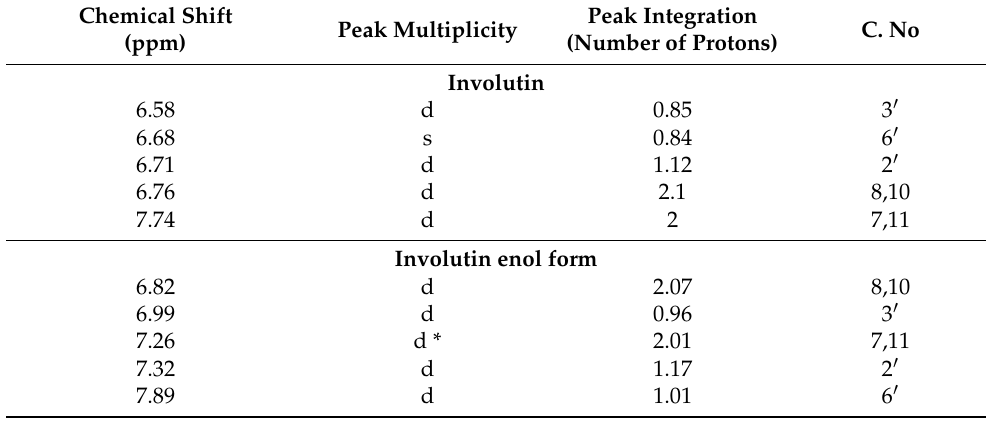
Table 3. Assignment of the peaks in 1 H NMR spectra (at 500 MHz) of HPLC-purified involutin in the region of 6.5 to 7.9 ppm. The multiplicity and integrals are relative to the most stable involutin form and a tautomeric form (enol). Multiplicity: singlet (s), doublet (d) and distorted doublet (d *). The NMR spectra are shown in Figure S3, along with the carbon number assignment (C. No) on the molecular structure.